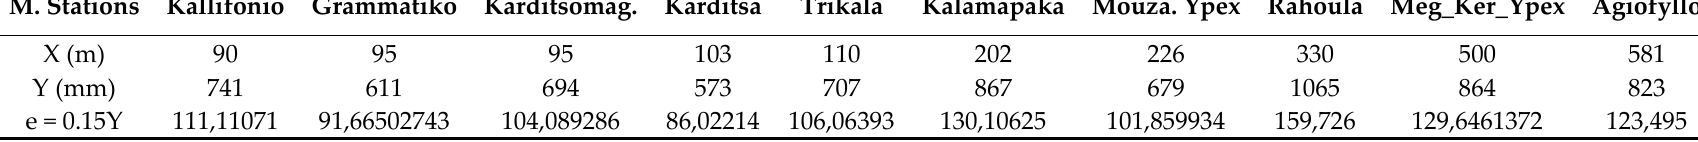
Table 1. Elevation and Rainfall data from meteorological stations of Central Thessaly.